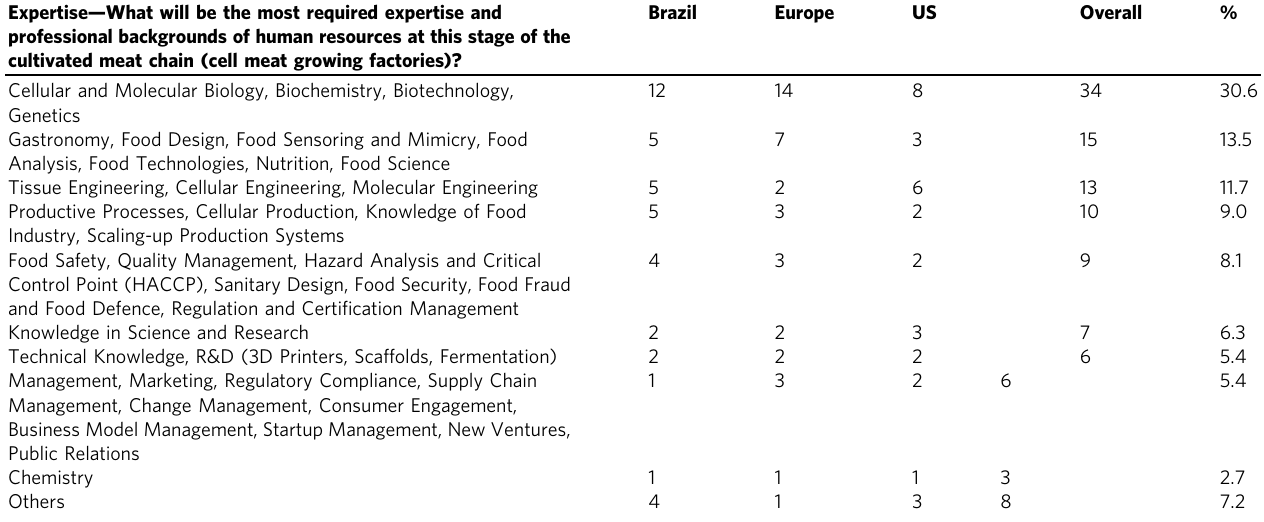
Table 11 Results regarding the most required expertise and background knowledge of human resources at the second stage of the cultivated meat value chain in Brazil ( N = 26), Europe ( N = 25) and the United States ( N = 21), using an open-ended question.